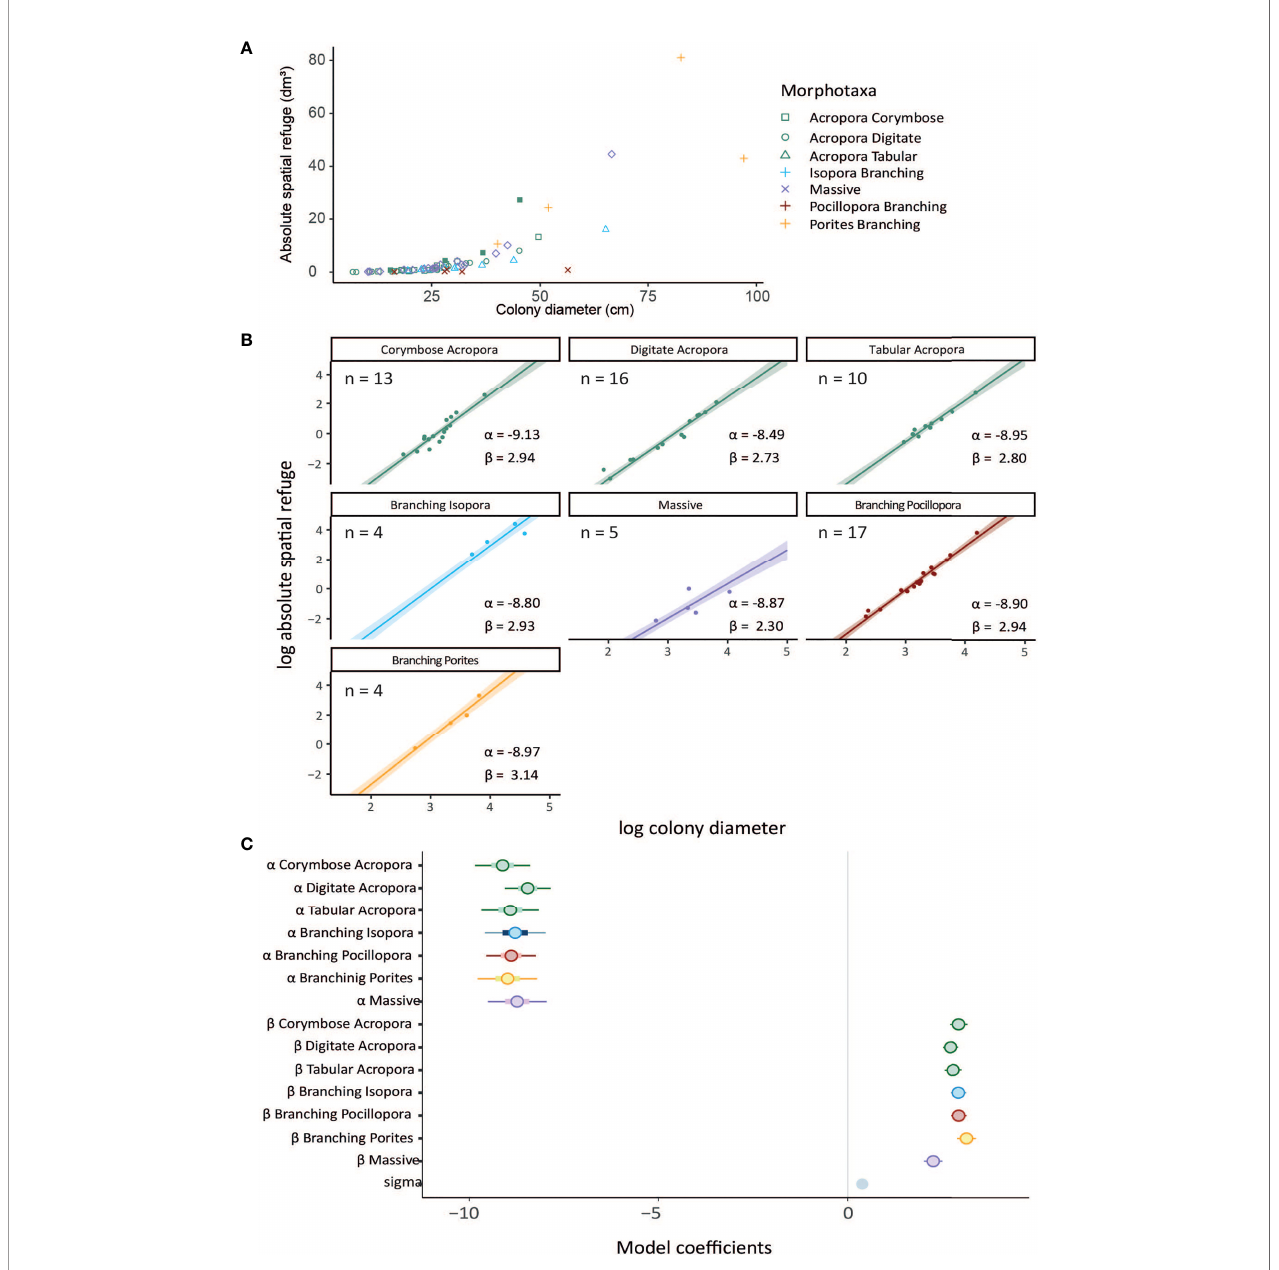
FIGURE 2 | (A) Scaling of absolute spartial refuge with increasing colony diameter across all morphotaxa. (B) Plotted posteriors from log-log linear model of absolute spatial refuge (mean centred) from the interaction model containing colony diameter as a predictor for each of the seven coral morphotaxa as well as intercept ( a ) and slope ( b ) estimates. Shaded regions are 95% highest density probability distribution. (C) Posterior predictions for intercept a and b parameters in the model. Straight line slope parameters indicate the existence of power-law relationships, with steeper slopes corresponding to higher power-scaling. Points indicate means, thick bars are 50% credible intervals, thin blue lines are 95% credible intervals. Numerical values off all model coef fi cients including posterior uncertainty are included in Table S1